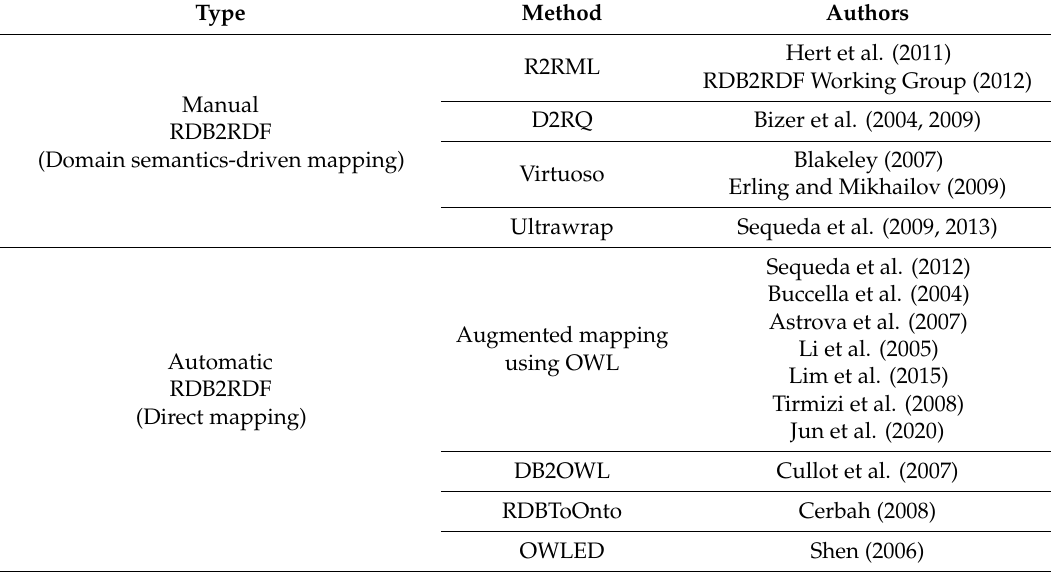
Table 1. Classification of previously reported mapping